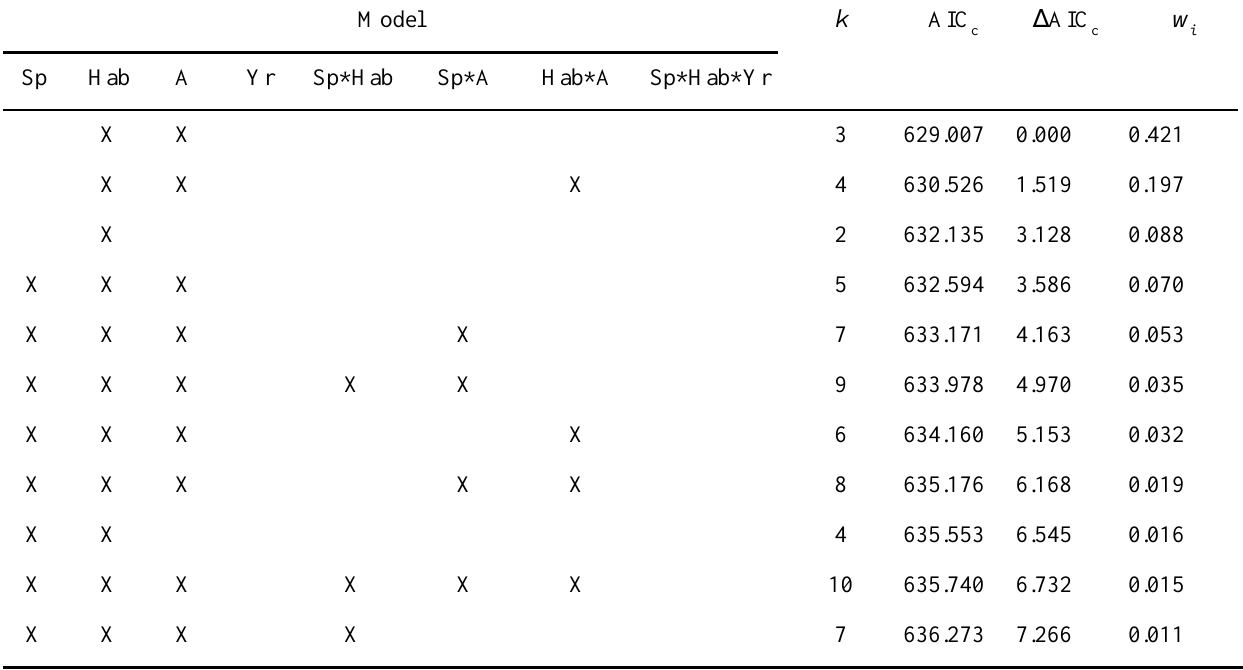
Table 3. Model selection results for daily nest survival for obligate grassland breeding birds, Iroquois National Wildlife Refuge. The top 11 out of 38 models are shown (those with AICc weights, w than 0.01). The models are described by indicating which main effects and interactions were included (Sp = species, Hab = habitat, A = area, Yr = year), and the number of parameters, k , they